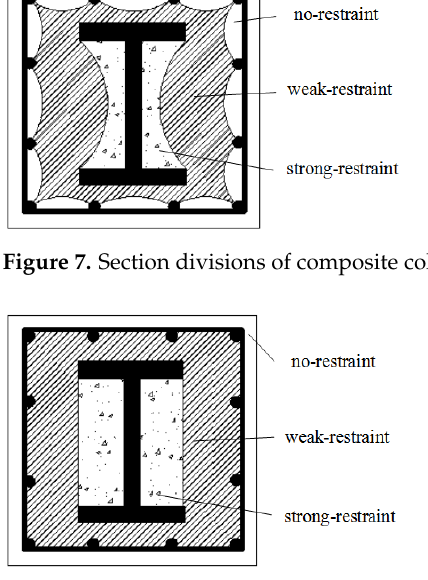
Figure 8. Regions simplified for composite sections.